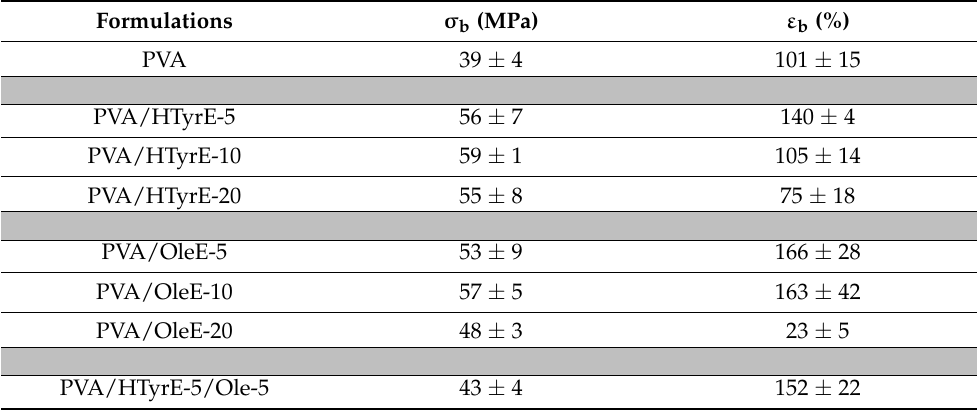
Table 2. Mechanical properties of PVA based films.